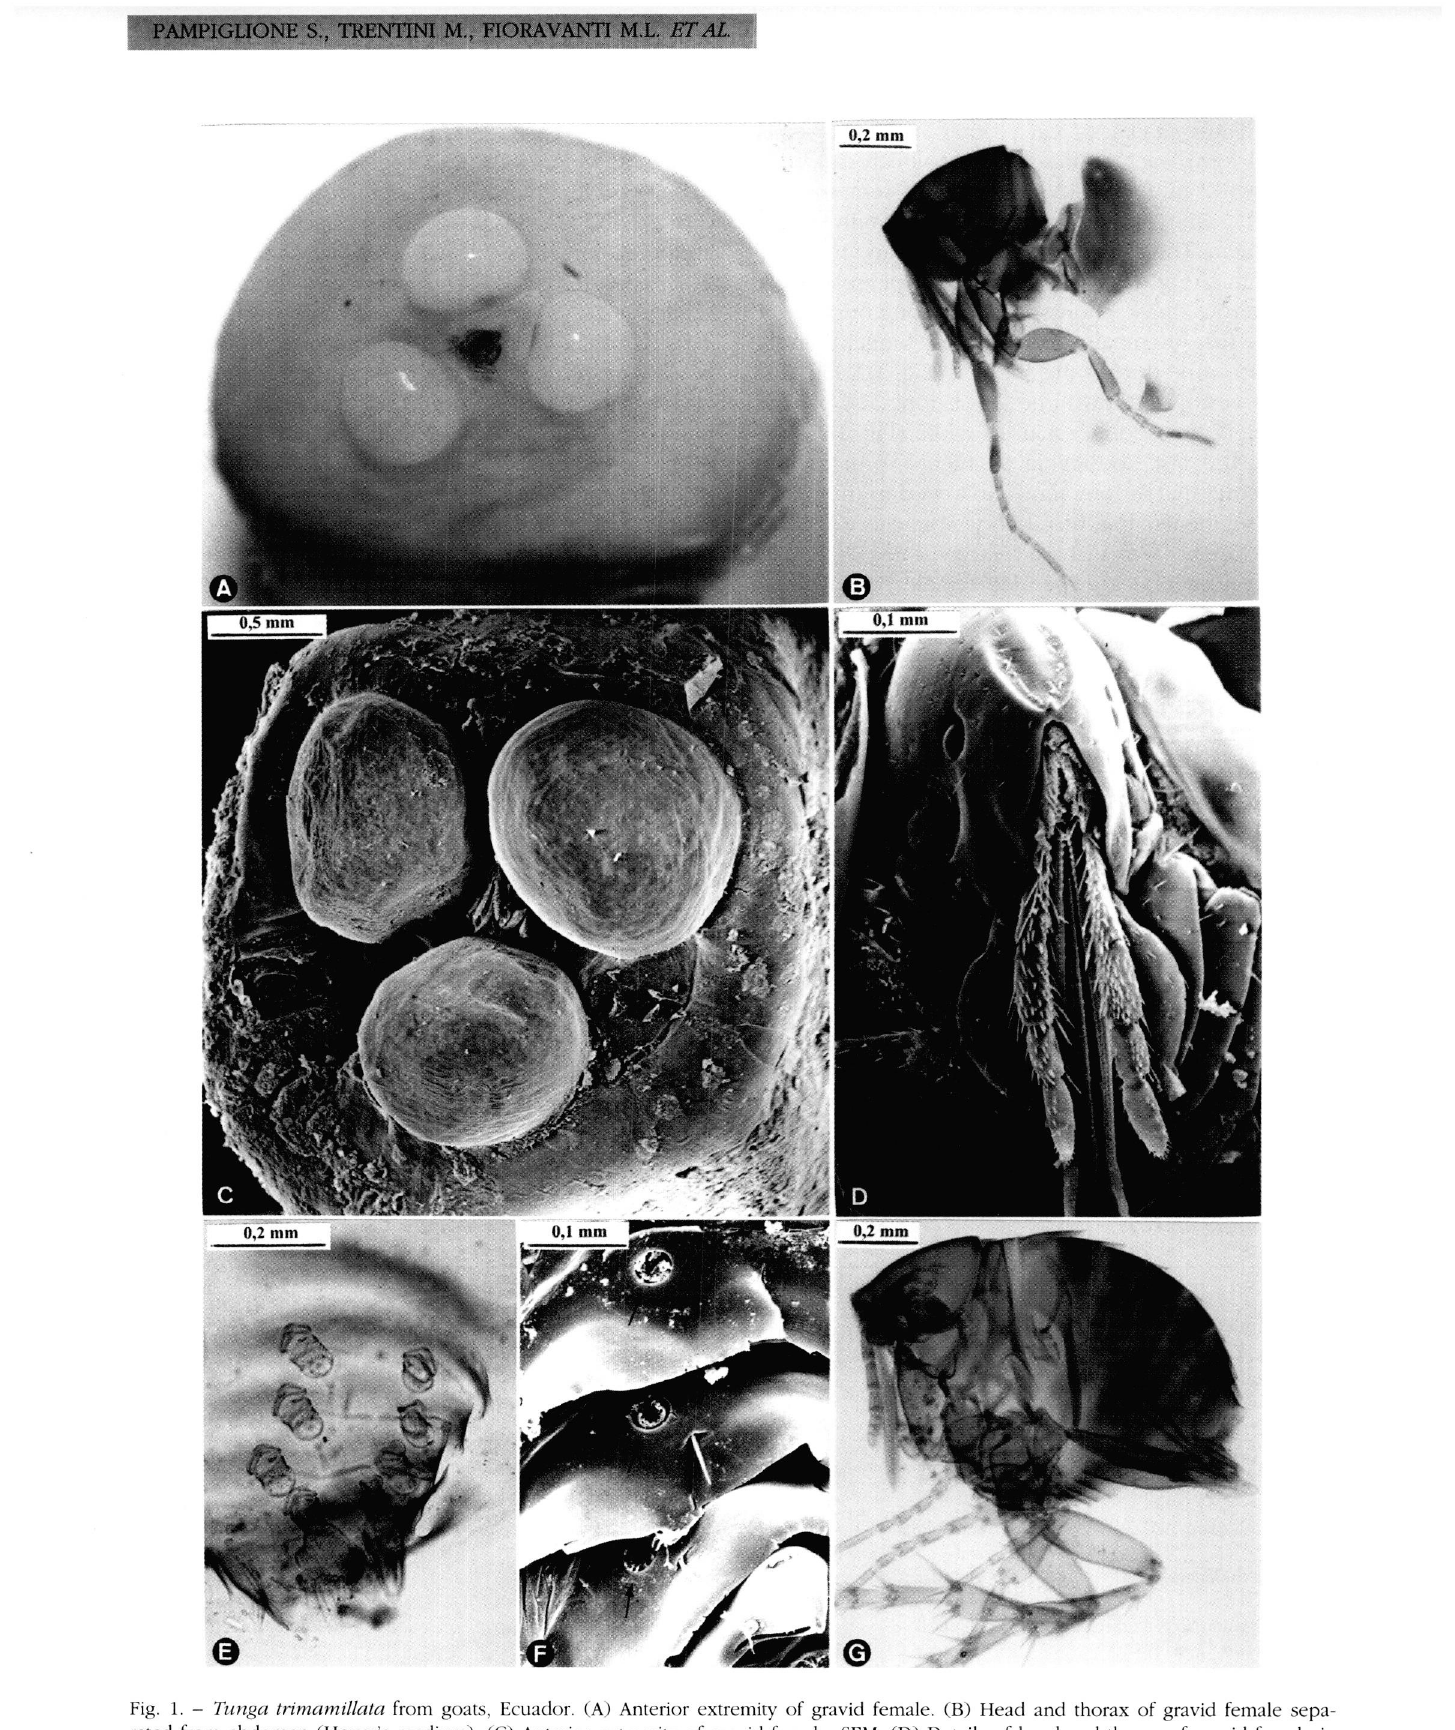
Fig. 1. - Tunga trimamillata from goats, Ecuador. (A) Anterior extremity of gravid female. (B) Head and thorax of gravid female sepa­ rated from abdomen (Hoyer's medium). (C) Anterior extremity of gravid female, SEM. (D) Details of head and thorax of gravid female in frontal view, SEM. (E) Respiratory spiracles of last abdominal segments of gravid female (Hoyer's medium). (F) Respiratory spiracles (arrows) of 5 th , 6 ,h and 7 lh abdominal segments, SEM. (G) Male (Hoyer's